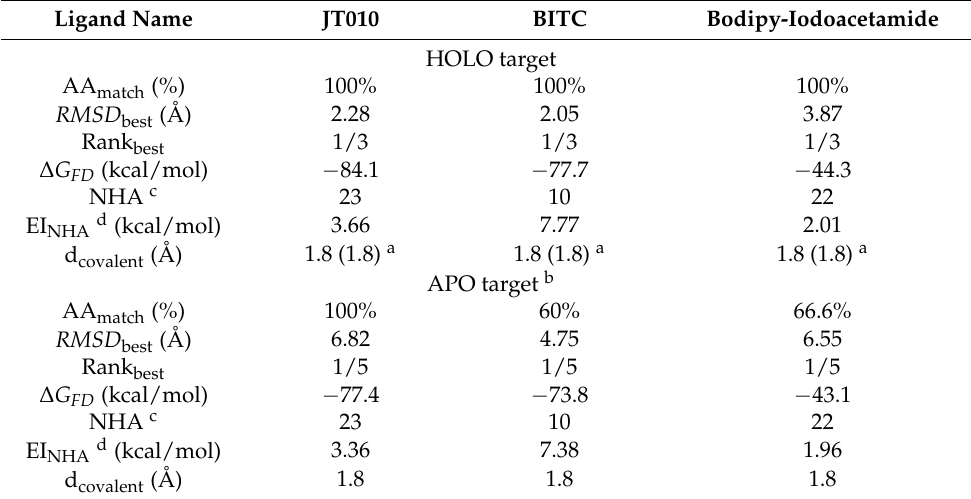
Table 1. Covalent docking calculations performed by FITTED